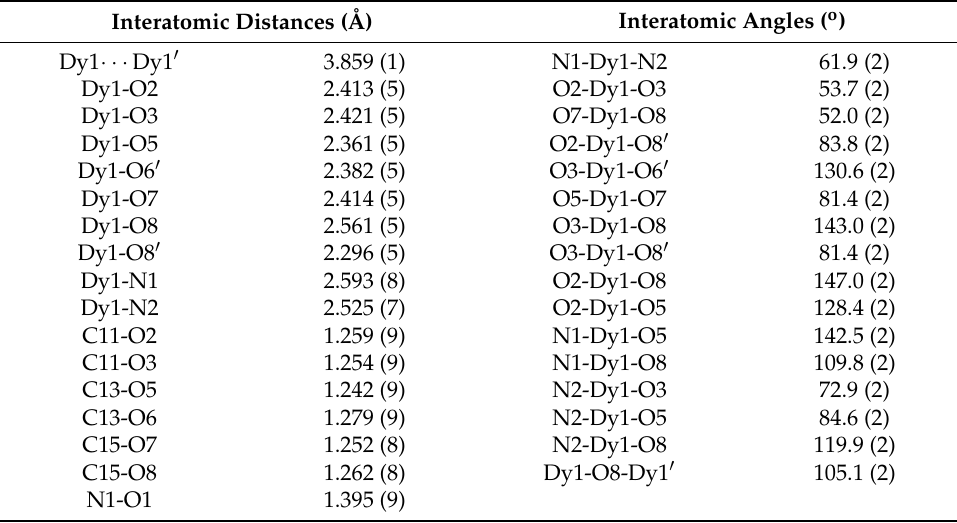
Table 2. Selected interatomic distances (Å) and angles ( o ) for complex 6 a